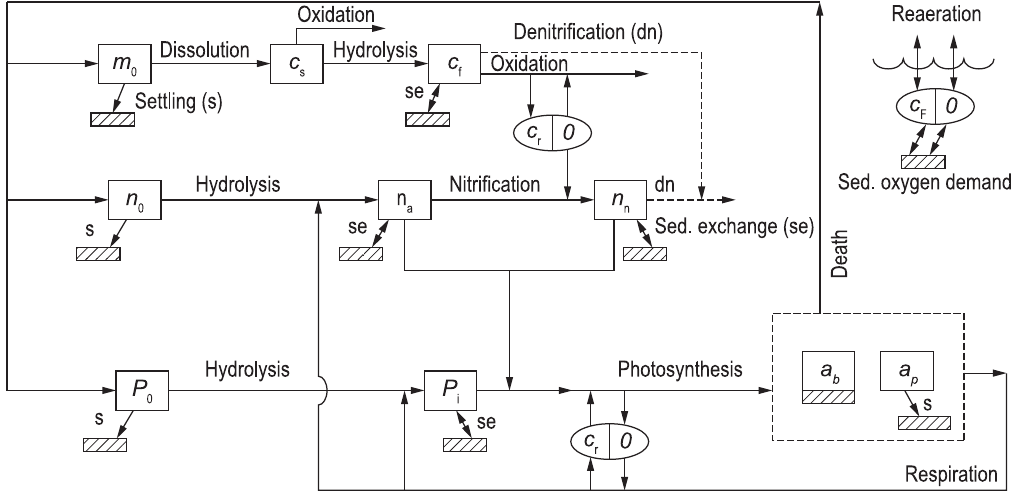
Figure 4. Schematic diagram of interacting water quality state parameters, a detritus, c : slow CBOD, c s trogen, n : nitrate nitrogen, p n